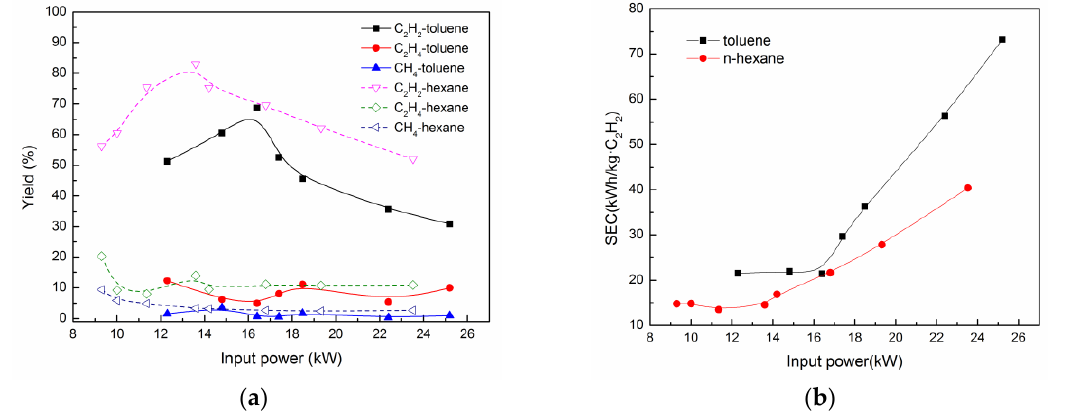
Q = 4.0 Nm 3 /h, Q = 4.0 Nm 3 /h, = 4.0 Nm 3 /h, 2 H 2 2 H = 5.0 Nm 3 /h, m-toluene = 2